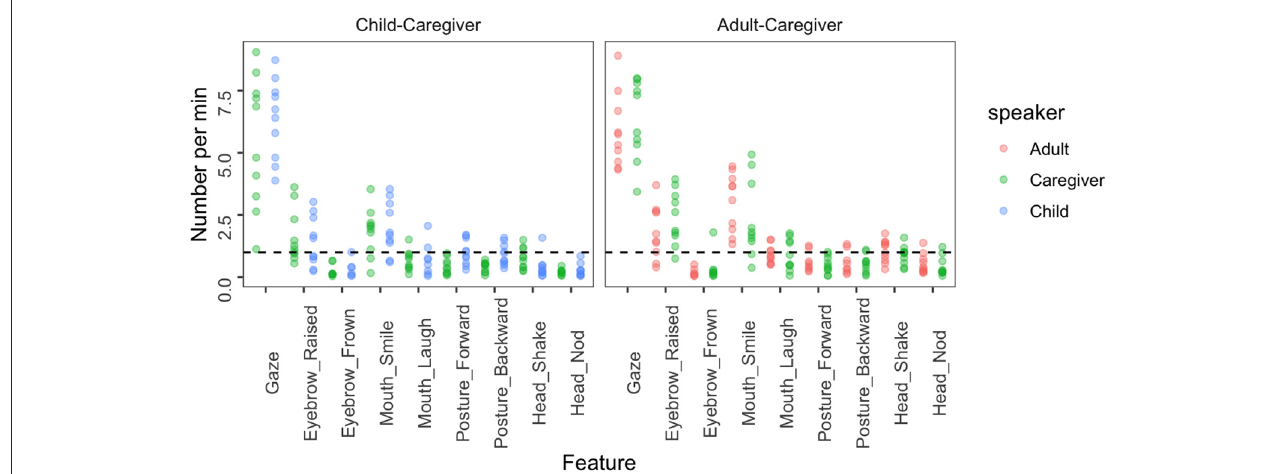
FIGURE2 The frequency of use of non-verbal features for each participant in our corpus. The frequency was normalized by the total length (in minutes) of the conversation. The black dotted line represents a frequency of 1 per minute; data above this line can be understood as indicating relatively frequent